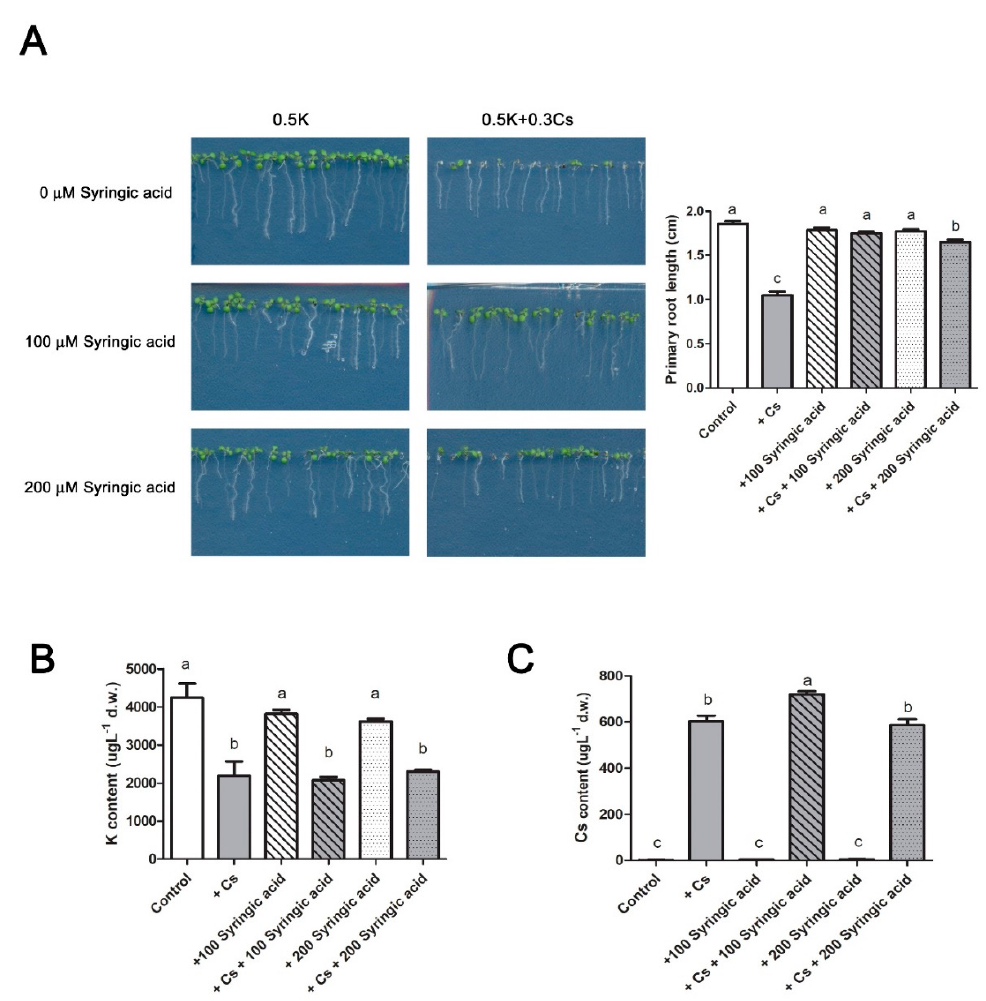
Figure 2. Application of syringic acid alleviates cesium-induced growth inhibition. ( A ) Wild-type Arabidopsis Col-0 was grown on media containing 0.5 mM potassium (K) and 0.3 mM cesium (Cs) supplemented with 0 µ M, 100 µ M, or 200 µ M syringic acid for 8 days. Potassium ( B ) and cesium ( C ) levels were quantified for each treatment. Statistically significant di ff erences were determined by a one-way ANOVA with Bonferroni’s multiple comparison post-test and indicated with di ff erent letters ( n > 60 seedlings, p < 0.05). Error bars represent the SE.